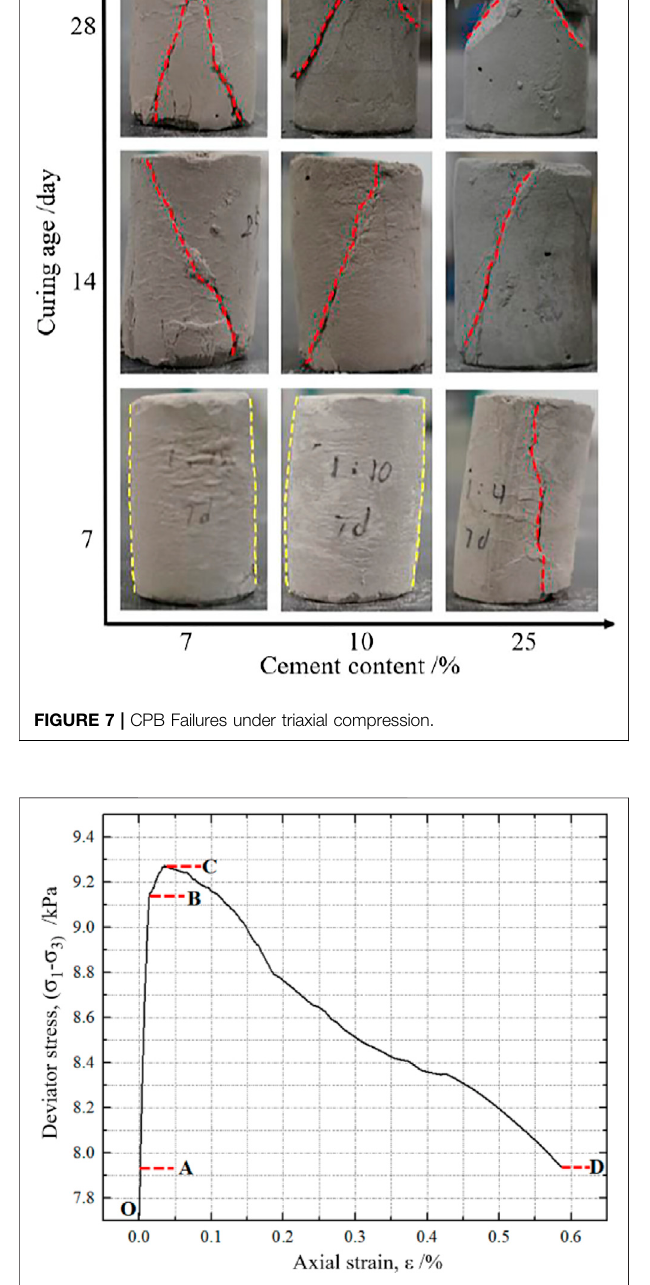
FIGURE 8 | Stress – strain curve of CPB in triaxial compression.